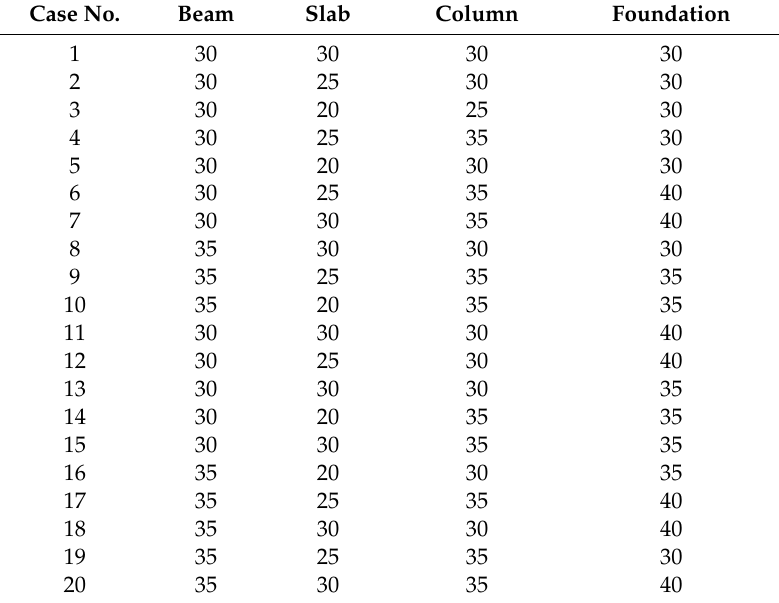
Table 1. Optimization of characteristic strength of concrete (f ck ) as a case study for the residential houses. Case No. Beam Slab Column Foundation 1